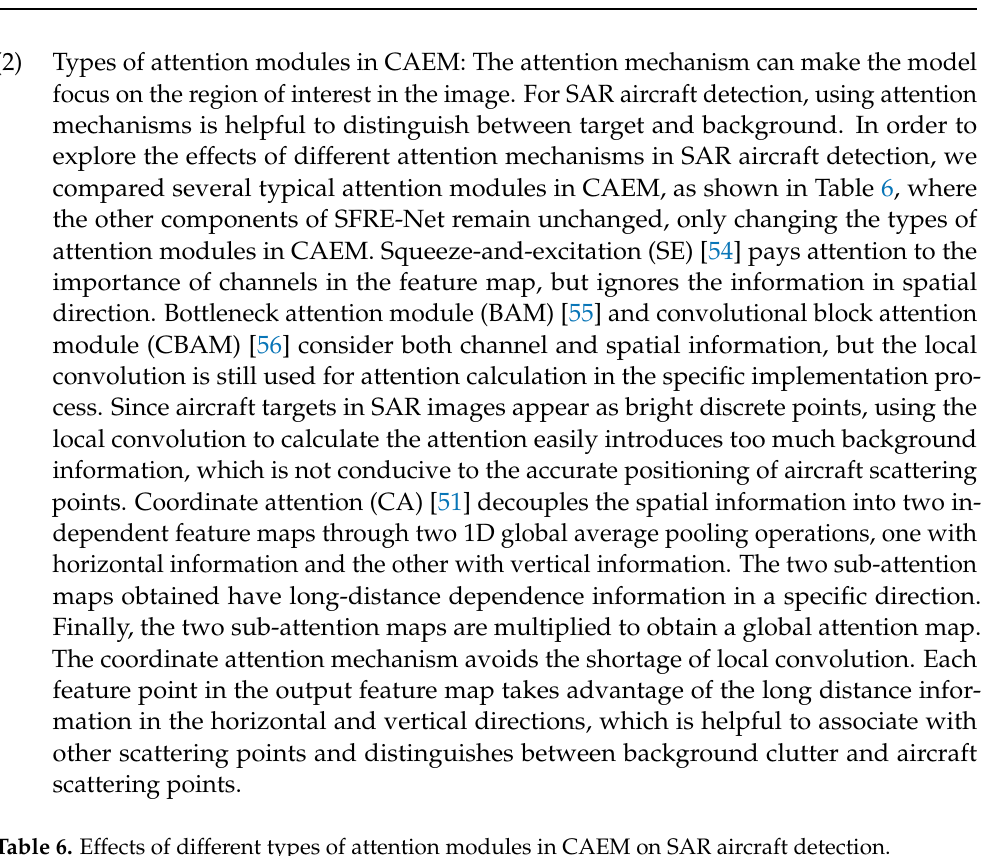
Table 6. Effects of different types of attention modules in CAEM on SAR aircraft